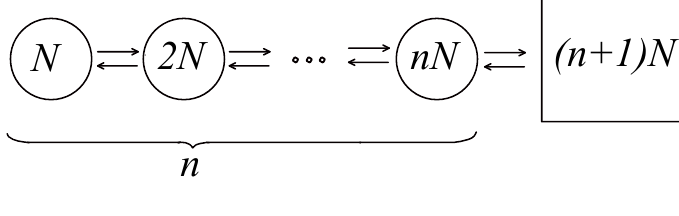
Figure 2 . Ascending